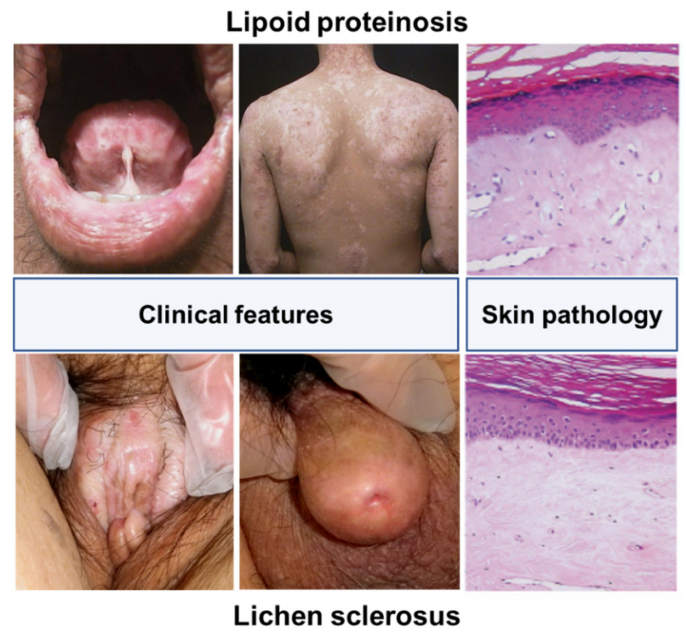
Figure 3. Clinicopathology of lipoid proteinosis (an ECM1-lacking genodermatosis: upper panels ) and lichen sclerosus (an anti-ECM1 autoantibody-carrying condition in females and males; left and right in the lower panels, respectively ). Irrespective of a predilection to different skin sites between the two diseases, their skin pathologies display similar features ( right columns ), including packed and parakeratotic hyperkeratosis, epidermal atrophy, and diffuse hyaline changes and dilated blood vessels in the upper dermis. Of these, dermal hyalinosis is a hallmark of both